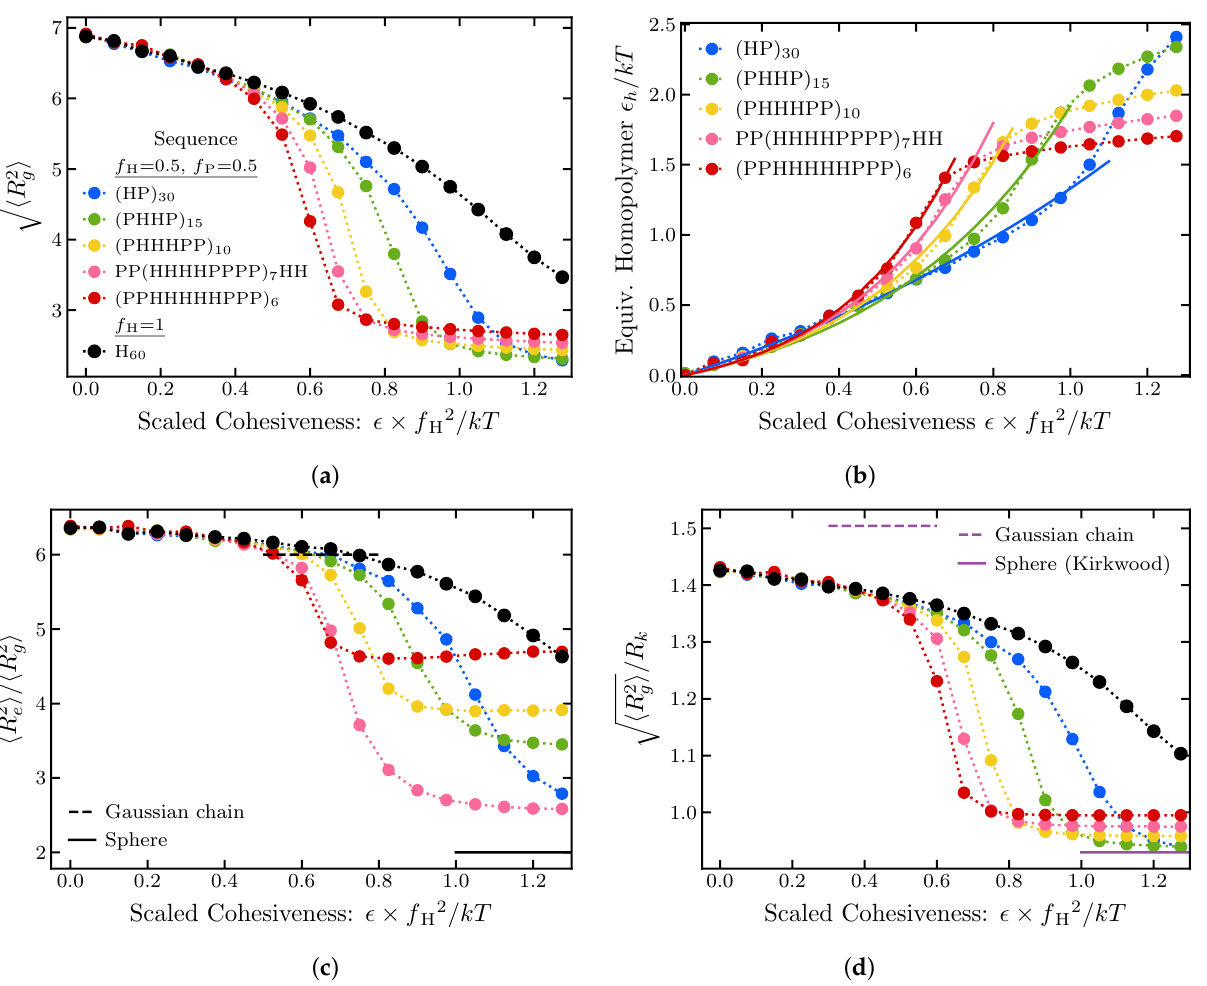
R 2 g . (cid:104) (cid:105) (cid:113)